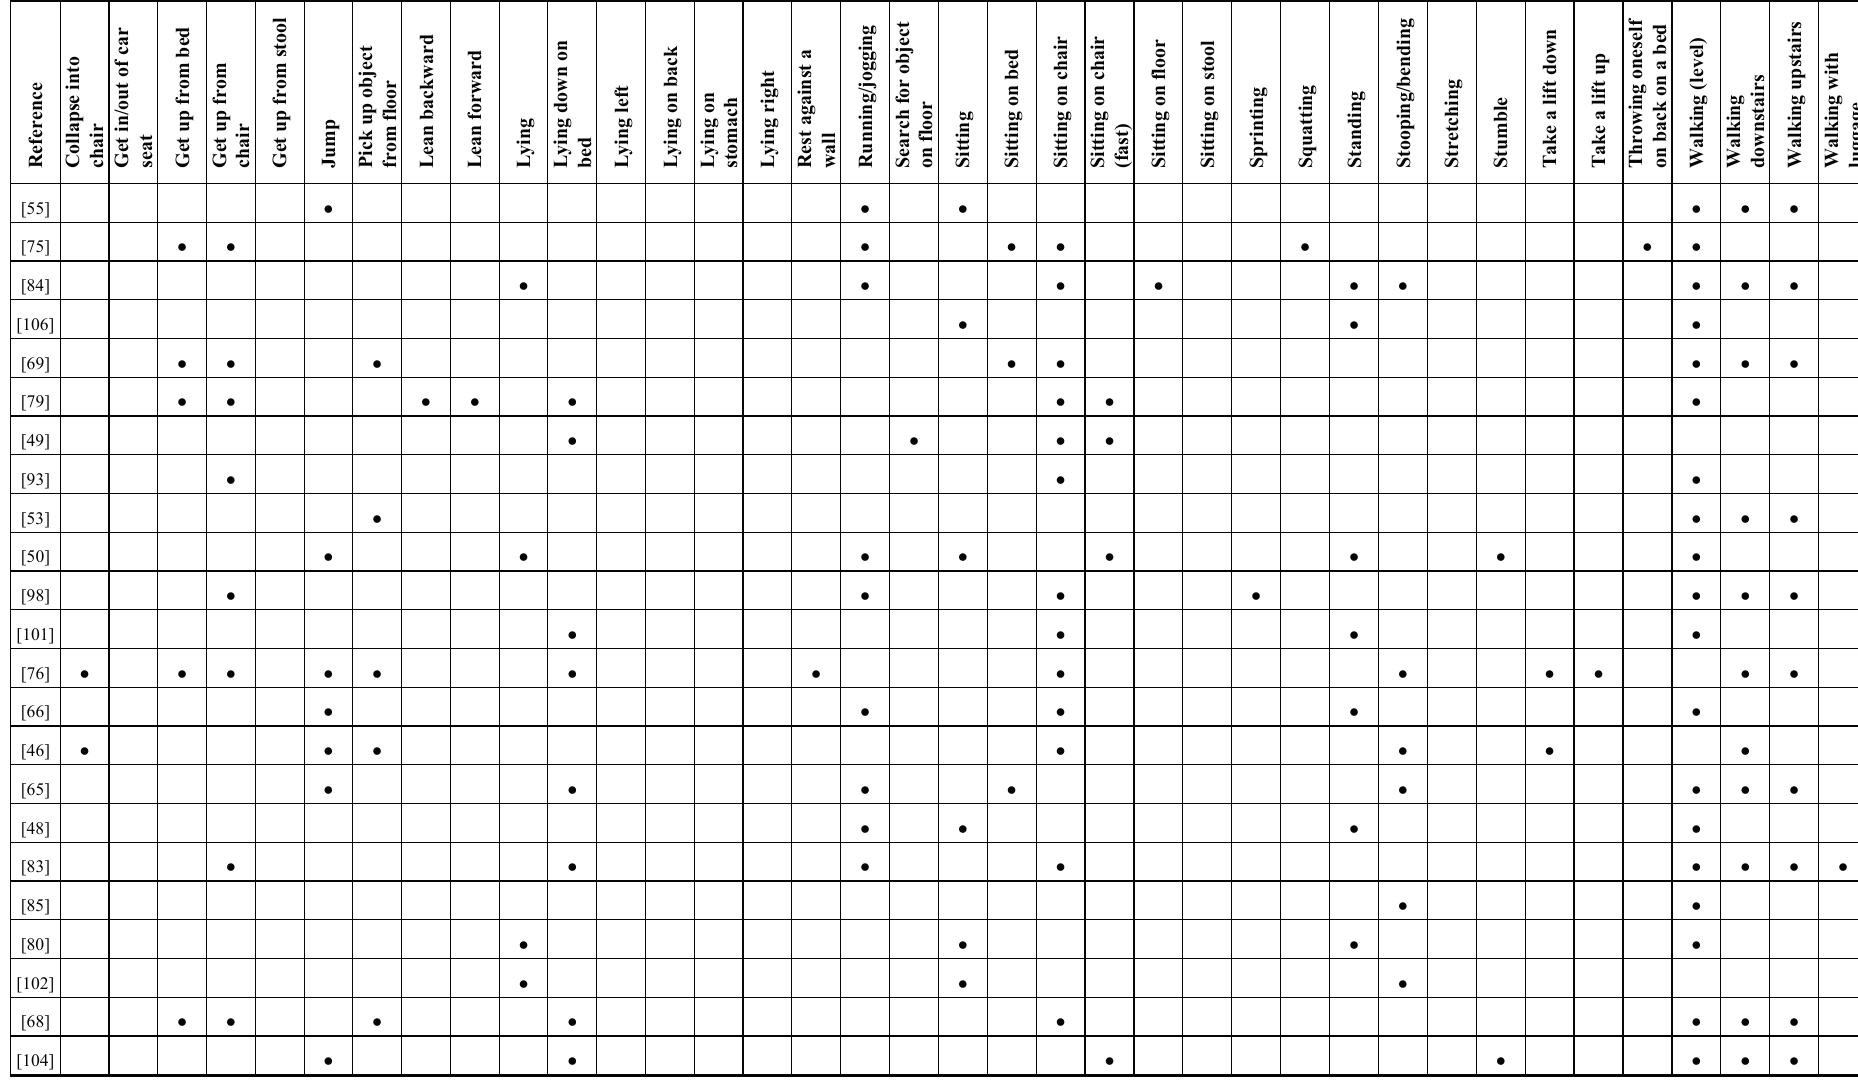
Table 2. Activities of Daily Living (ADL)